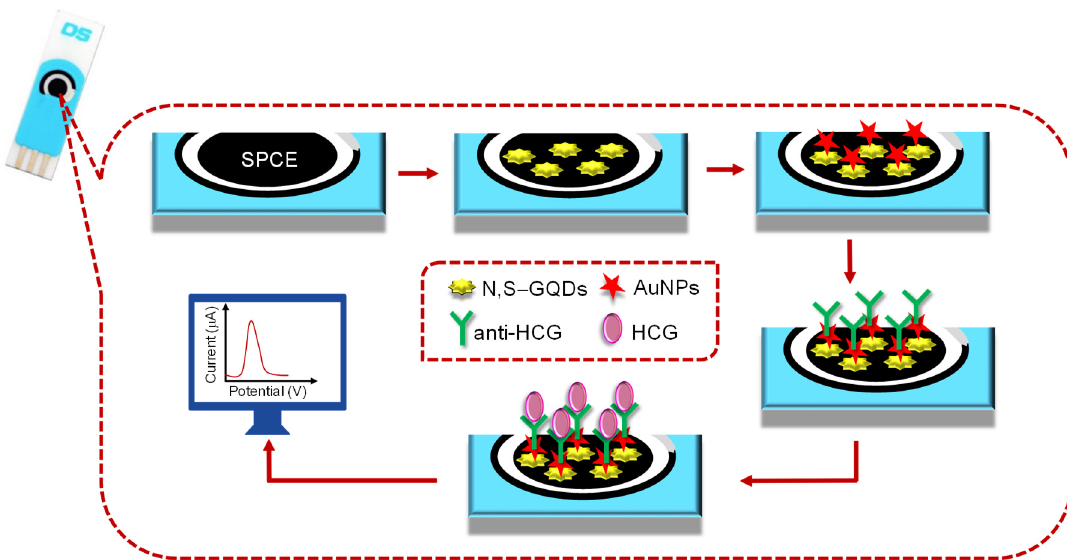
Figure 18. Various steps tangled in designing a GQD-based antibody sensor for tracking human chorionic gonadotropin (HCG) levels [79].